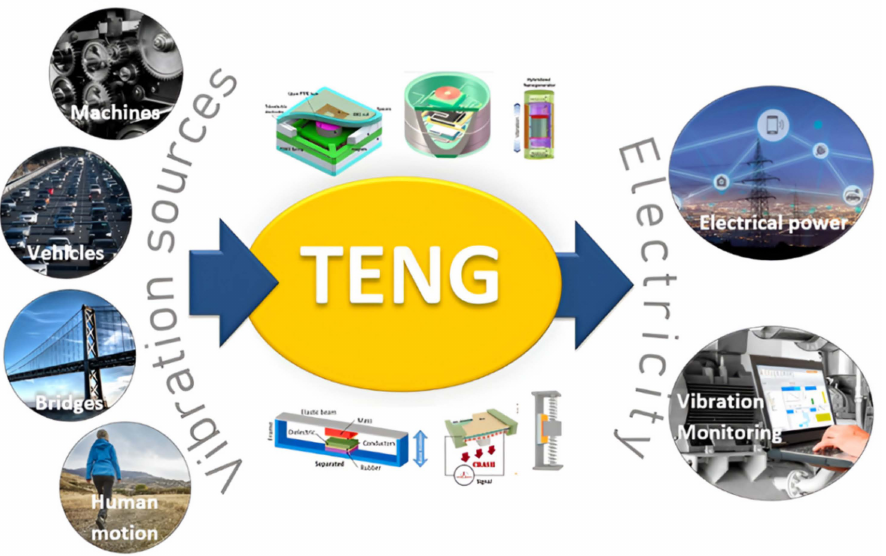
Figure 1. TENG can convert mechanical vibrations into electricity, which can be used for electrical powering or vibration sensing